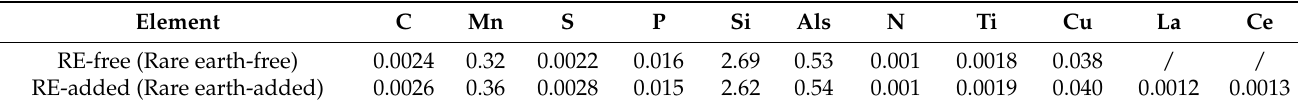
Table 2. Chemical composition of experiment steel (wt%).